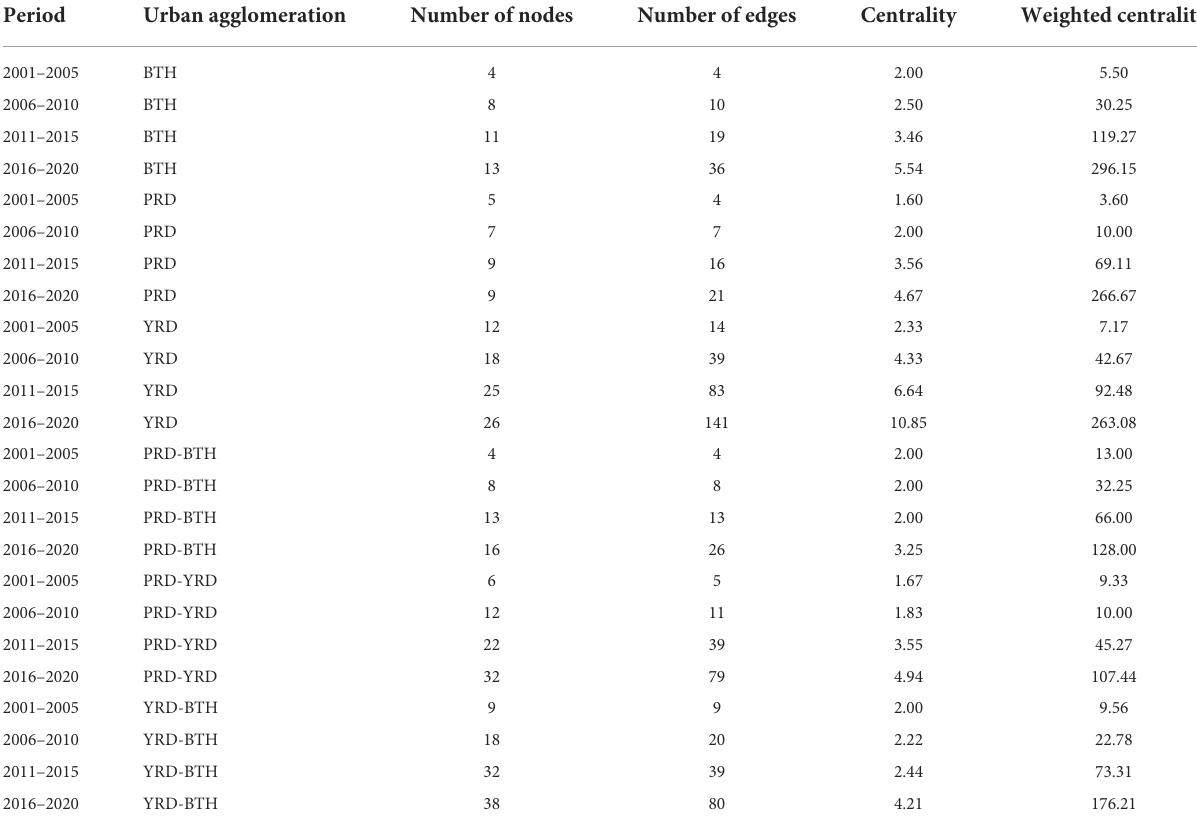
TABLE 5 Statistical characteristics of urban biomedicine innovation networks among BTH, YRD, and PRD. Period Urban agglomeration Number of nodes Number of edges Centrality Weighted